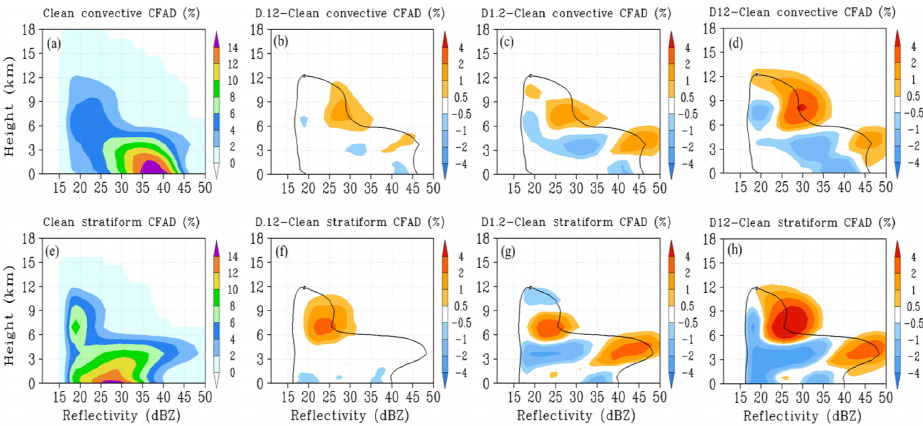
Figure 13. Contoured frequency by altitude diagrams (CFADs) of model-simulated convective (a–d) and stratiform (e–h) reflectivity. Columns: Clean case, D.12–Clean, D1.2–Clean, D12–Clean differences, respectively. Black contour line in difference plots represents the Clean case 2% contour value.